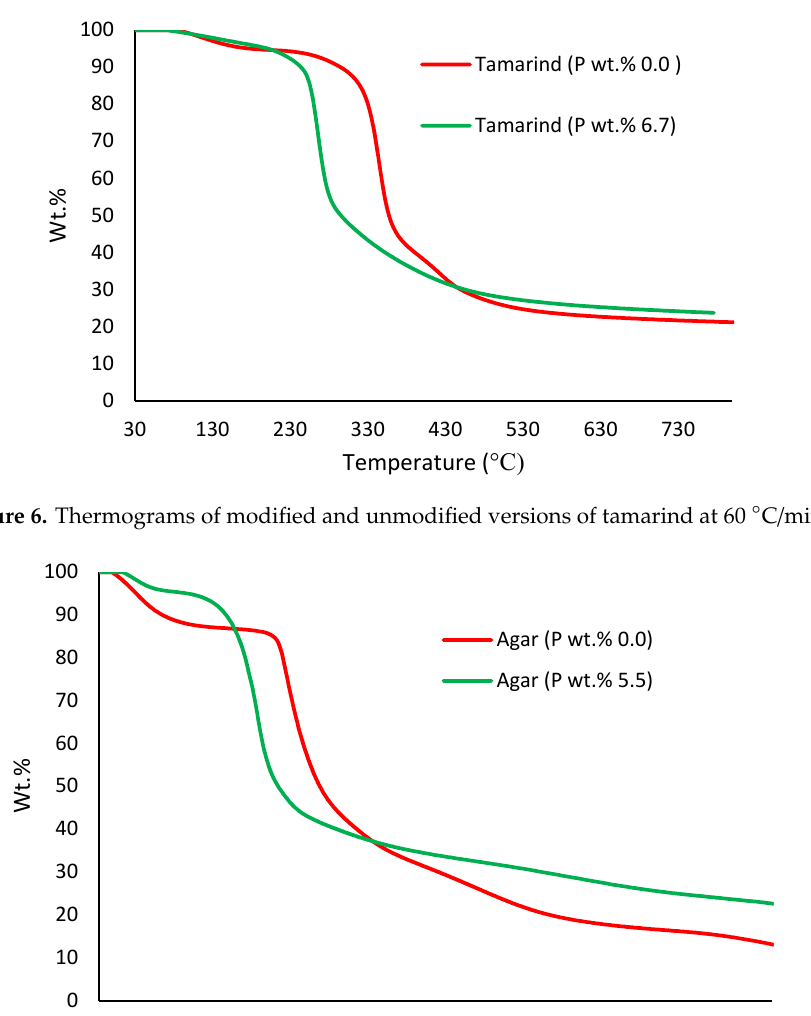
Figure 5. Thermograms of modified and unmodified versions of potato starch at 60 °C/min.